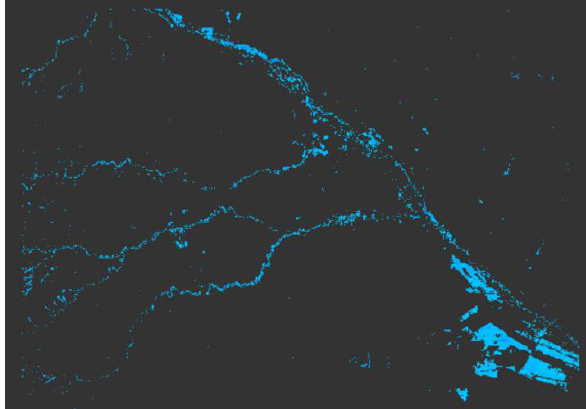
Figure 8. Flooded area according to